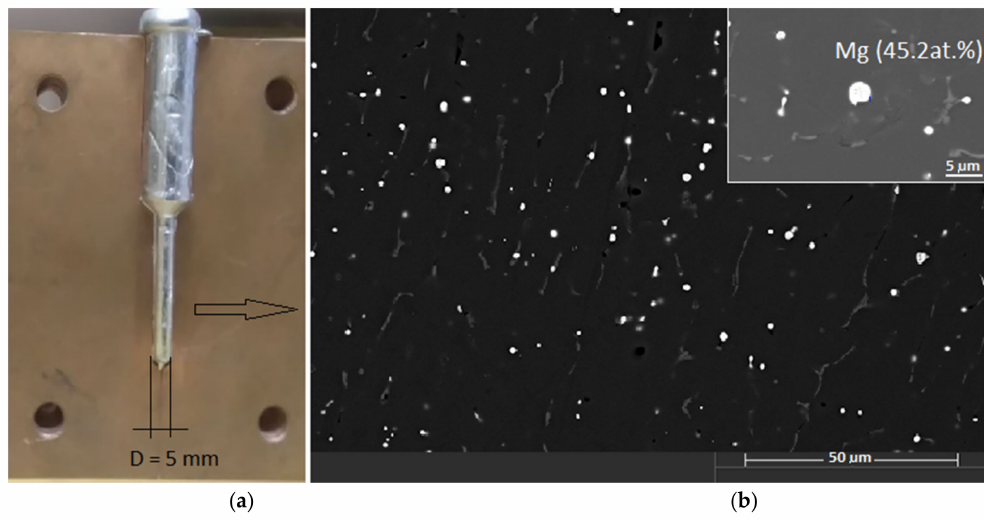
Figure 9. ( a ) Copper mold design; ( b ) Microstructure of the sample cast in copper mold (SEM).